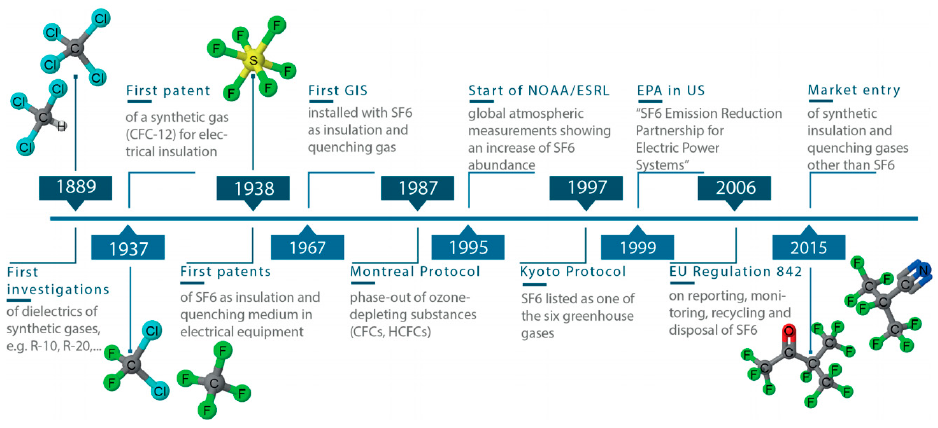
Figure 1. Development of insulating gases [7].